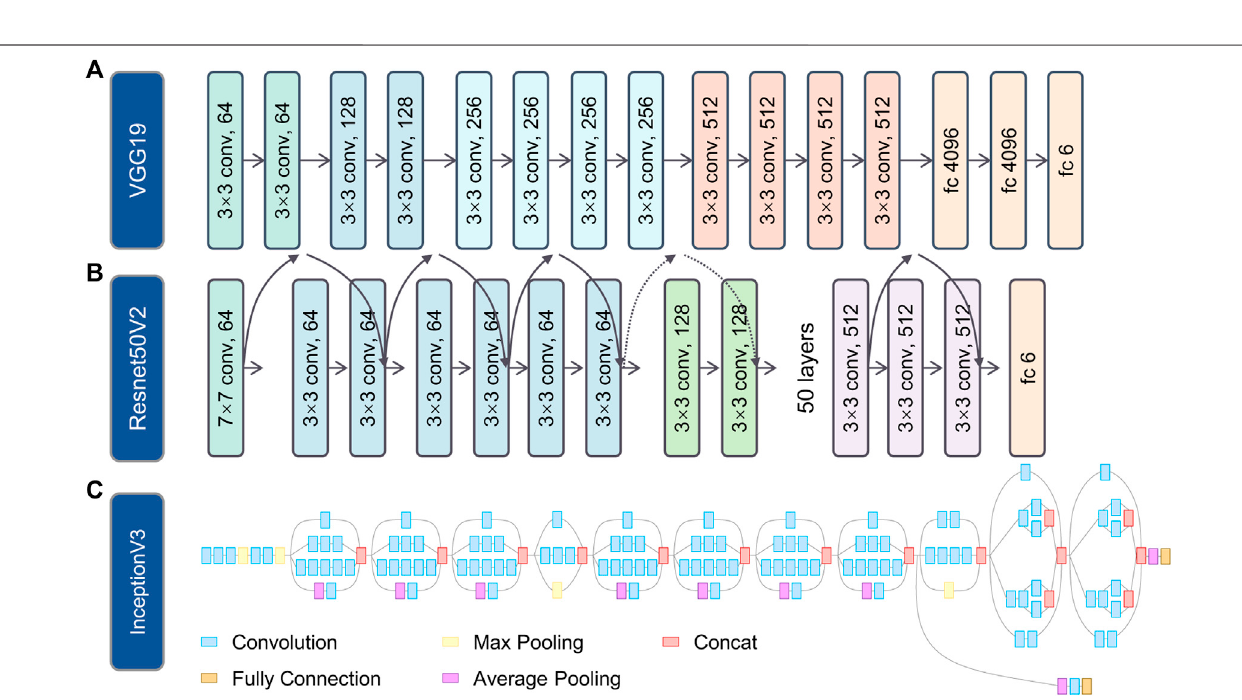
Frontiers in Built Environment |